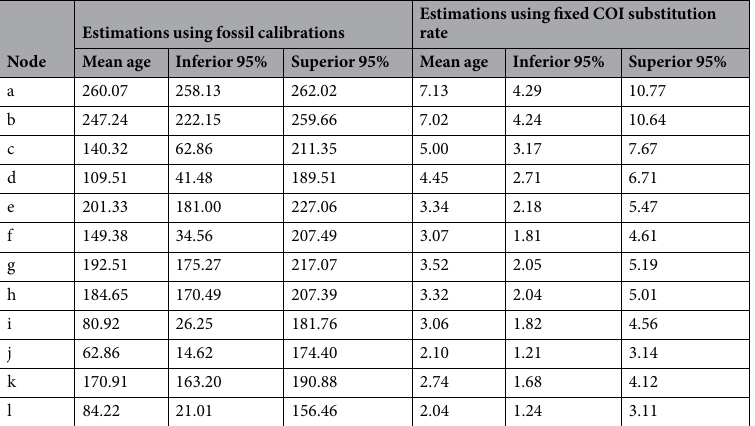
Estimations using fixed COI substitution rate